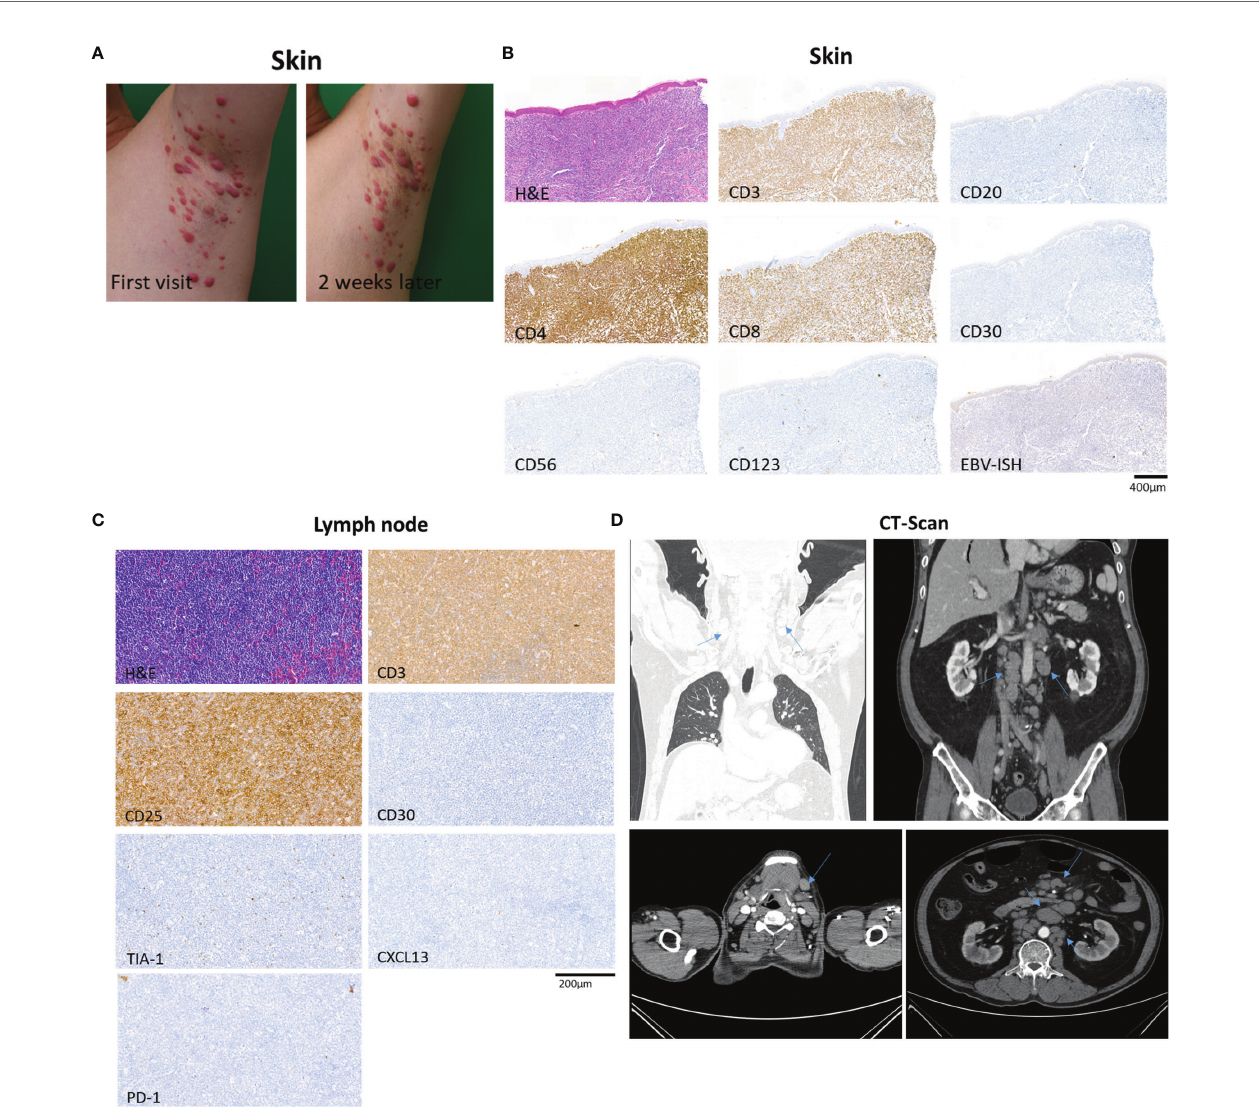
FIGURE 1 | Overview of a patient with adult T-cell leukemia/lymphoma involving skin and lymph node. (A) The patient ’ s skin lesions at fi rst visit and 2 weeks after the fi rst visit, showing rapidly progressing erythematous papules and nodules of the left axilla. (B) Biopsy specimen of skin showing dense in fi ltration of atypical lymphocytes with predominance of CD4+ over CD8+ T cells, and negative expression of CD30, CD20, CD56, and CD123. In situ hybridization of EBV was negative. (C) Excisional biopsy specimen of neck lymph node demonstrating CD4+ and CD25+ non-cytotoxic mature T-cell lymphoma involvement. (D) Computed tomography of chest, abdomen and pelvis showing abnormal lymph node enlargement (arrows) in the abdomen, pelvis, and bilateral neck, highly suspicious of lymphoma